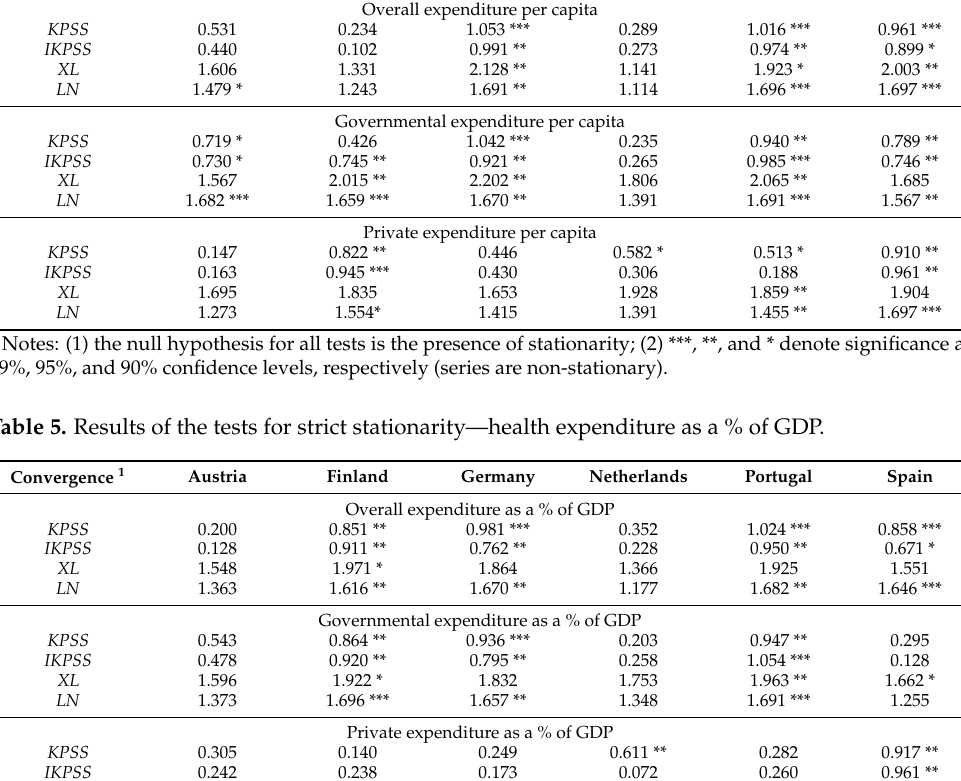
Table 4. Results of the tests for strict stationarity—health expenditure per capita. Convergence 1